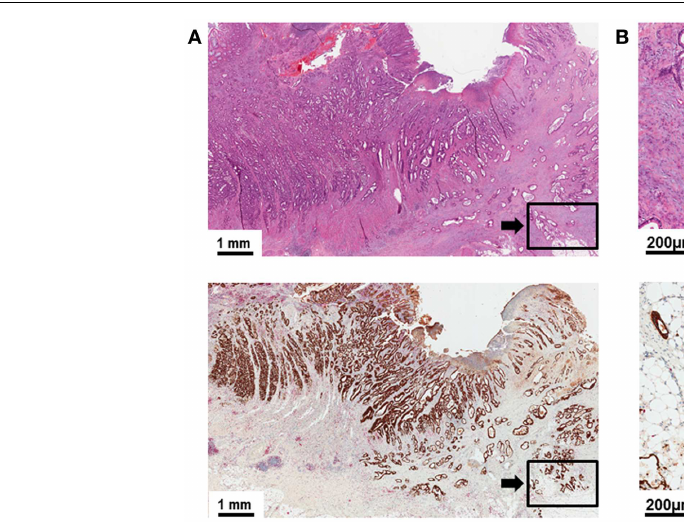
FIGURE 1 | (A) Low power image (5 × ) of a H&E slide and pan-cytokeratin (brown)/CD8 (red) double stain illustrating a transmurally invasive primary CRC with an infiltrative tumor border configuration. Delineation of tumor and host tissue is difficult in the H&E stain. Residual host tissue is present between infiltrating cords and sharp wedges of long-stretched tumor glands.